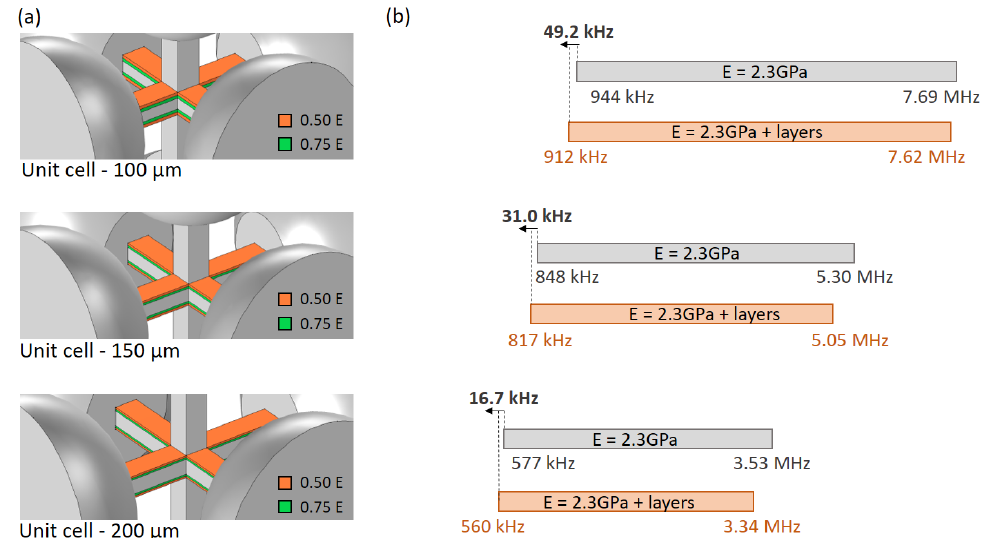
Figure 7. ( a ) Close-up view of the unit cell beams for a = 100, 150, 200 µm. The layered structure caused by the 2PP fabrication process is put in evidence: one , two , at least three overlapped layers areas are shown in orange, green and grey, respectively. ( b ) Bandgap simulated through dispersion analyses under the hypothesis of uniform Young’s Modulus (grey bars) and layered structure (orange bars). The reference Young’s modulus of 2.3 GPa was adopted for the uniform structure and for the at least three overlapped layers area, while reduced Young’s modula are adopted for the one and two overlapped layered